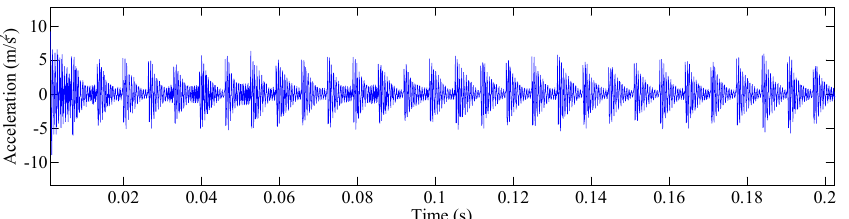
Figure 2. The acceleration response when the defect is on the outer raceway. In the same way, the acceleration response of the spindle nose in y direction when the defect is located on the inner raceway is shown in Figure 3.